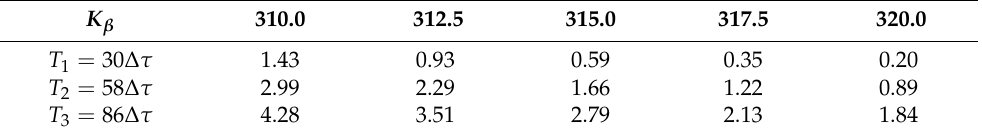
Table 1. KOSPI 200 index call option prices on 14 January 2020 with respect to the strike and maturity. Our data source is the market data system of the Korea Exchange (KRX Market Data System: https://data.krx.co.kr/, accessed on 19 June